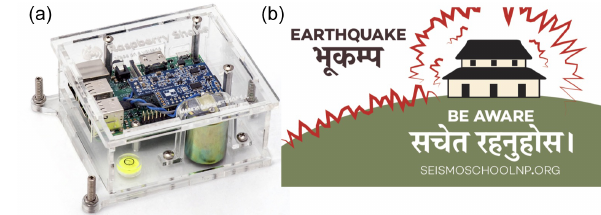
Figure 3. (a) The Raspberry Shake 1D low-cost seismometer, in- stalled in 22 schools across central Nepal (see Fig. 1). (b) Earth- quake awareness sticker, as a reminder, in English and the Nepali language (artwork of Mathias Dessimoz). The sticker’s image is available for download from our program’s web page at http://www. seismoschoolnp.org (last access: 18 September